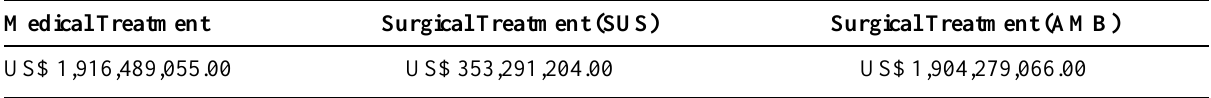
Table 6 – Total annual estimate costs needed for treatment of BPH in Brazil in